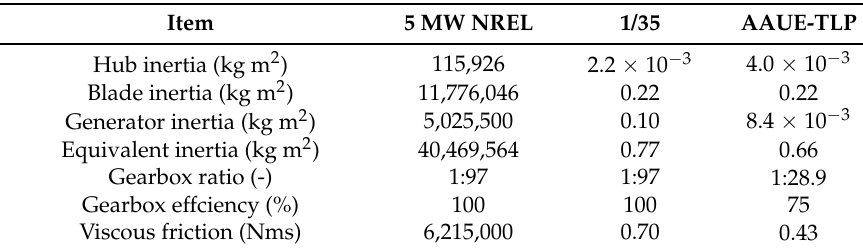
Table 3. Drive train properties.